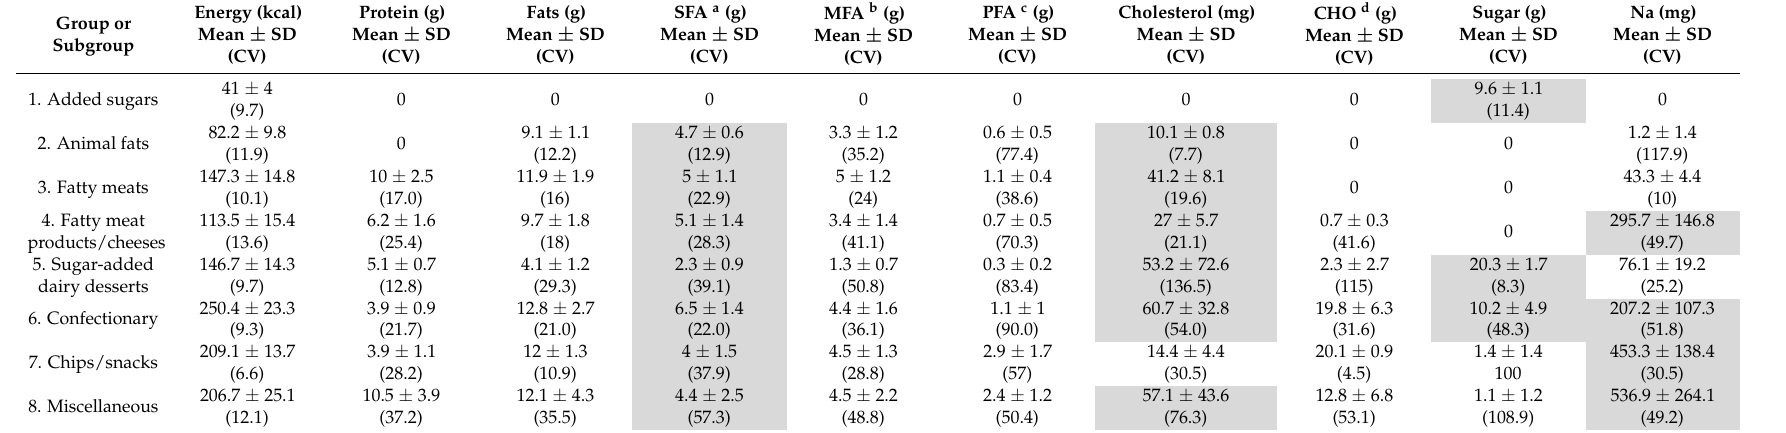
Table 3. Mean nutrient content, standard deviation (SD) and coefficient of variation (CV) of food groups based on servings of foods. Group or